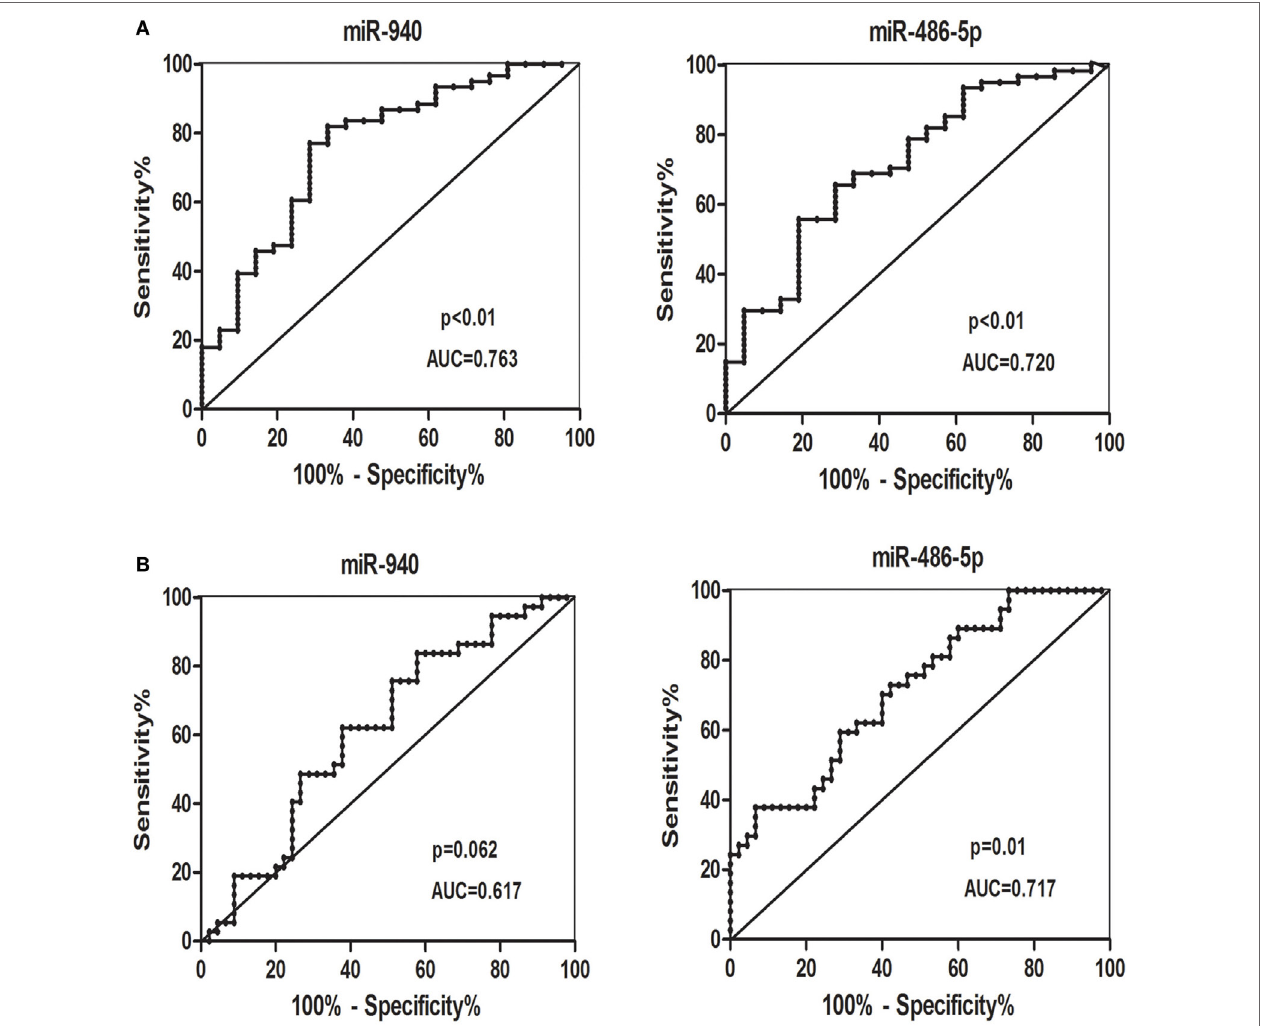
FigUre 5 | (a) Receiver-operating characteristic (ROC) curves for the ability of the differentially candidate serum microRNAs (miRNAs) to differentiate the patients with subclinical hypothyroidism (SCH) + spontaneous abortion (SA) from the other groups [SCH, SA, and healthy control (HC)]. (B) ROC curves for the ability of differentially expressed candidate serum miRNAs to differentiate all patients with SCH (SCH + SA and SCH) from the other groups (SA and HC). Abbreviation: AUC, area under the